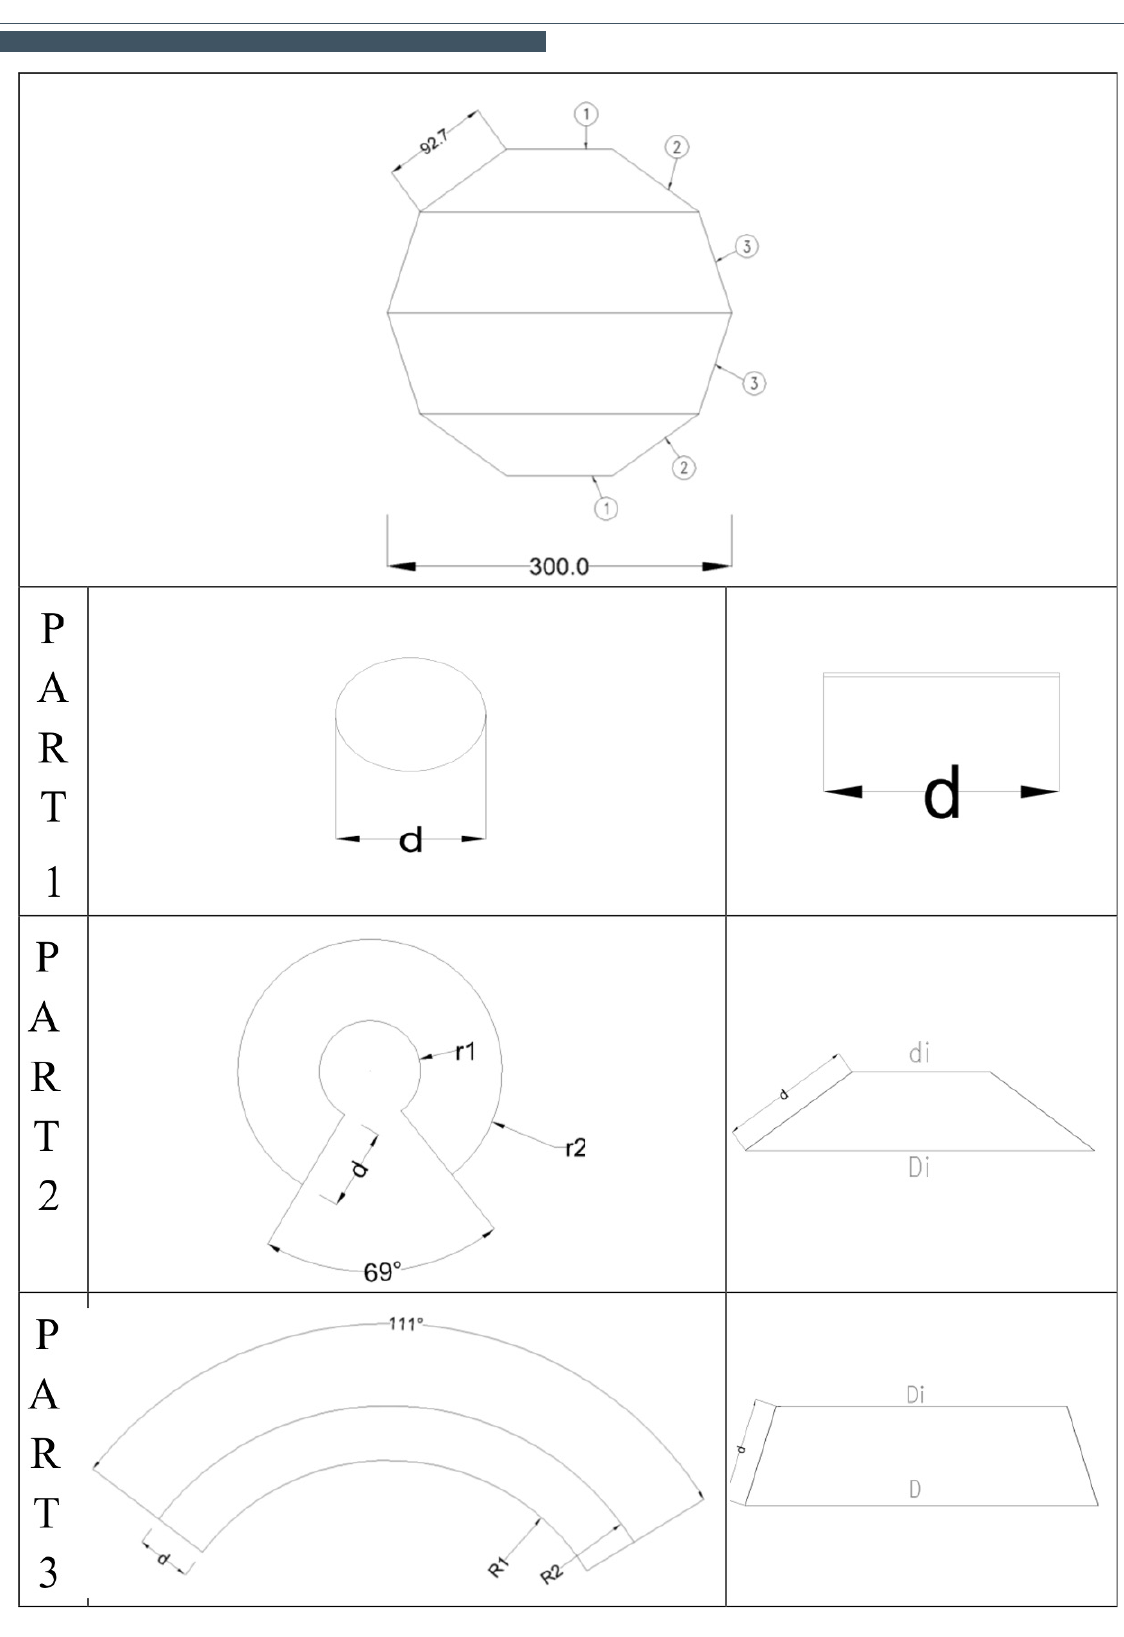
Figure 3. Different components of the model before (left) and after (right) rolling